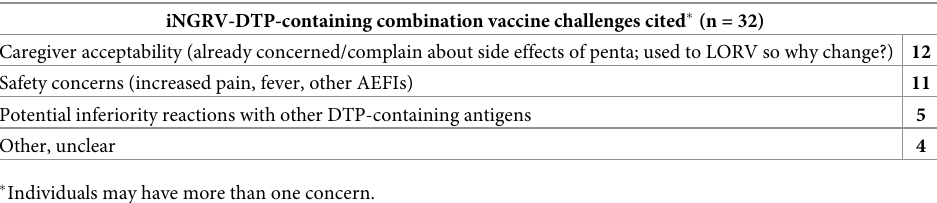
Table 7. Healthcare provider concerns for including iNGRV in a DTP-containing combination vaccine by type. iNGRV-DTP-containing combination vaccine challenges cited � (n = 32) Caregiver acceptability (already concerned/complain about side effects of penta; used to LORV so why change?) 12 Safety concerns (increased pain, fever, other AEFIs) Potential inferiority reactions with other DTP-containing antigens Other, unclear � Individuals may have more than one concern.